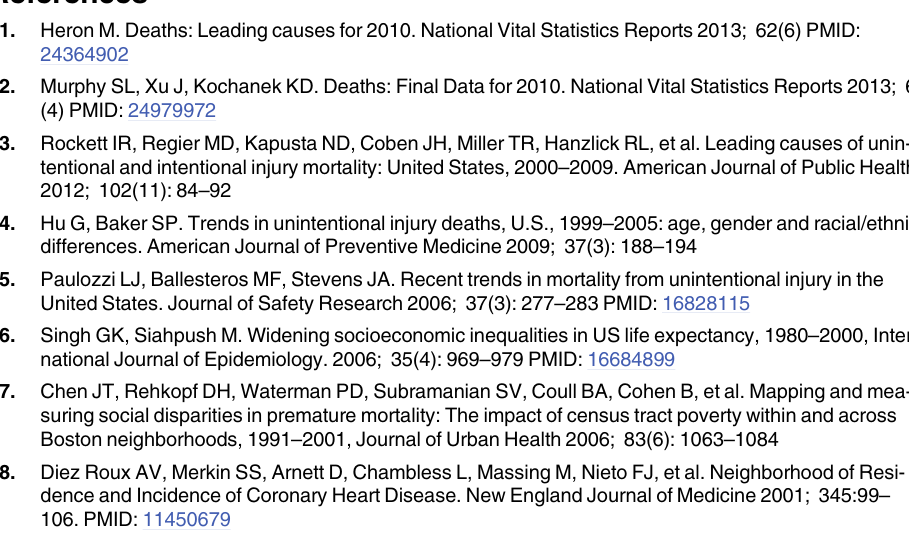
S1 Table. Table 2 Supplement: Relative Risk of Mortality from Unintentional Injury: United States 1999 – 2012. S2 Table. Fig 1 Supplement: Mortality Trends a by County Poverty Category. S3 Table. Table 3 Supplement: Injury Fatalities, Population Attributable Fraction, and Attributable Deaths for County Poverty, 1999 –